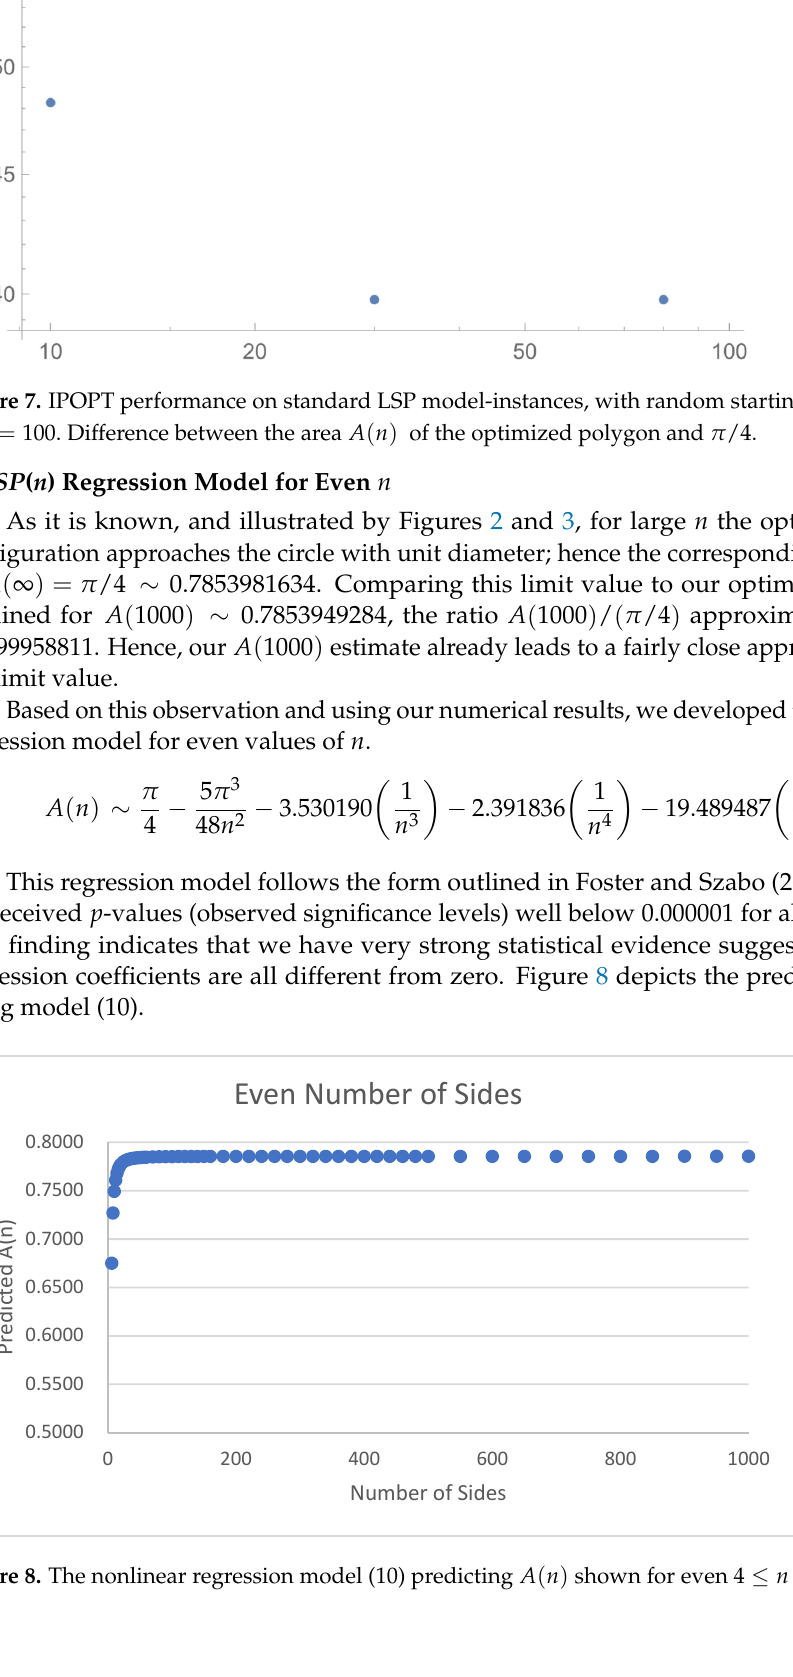
Figure 6. IPOPT performance on standard LSP model-instances, with the proposed starting solu- tion, up to 𝑛 = 300. Difference between the area 𝐴(𝑛) of the optimized polygon and 𝜋 4⁄ .